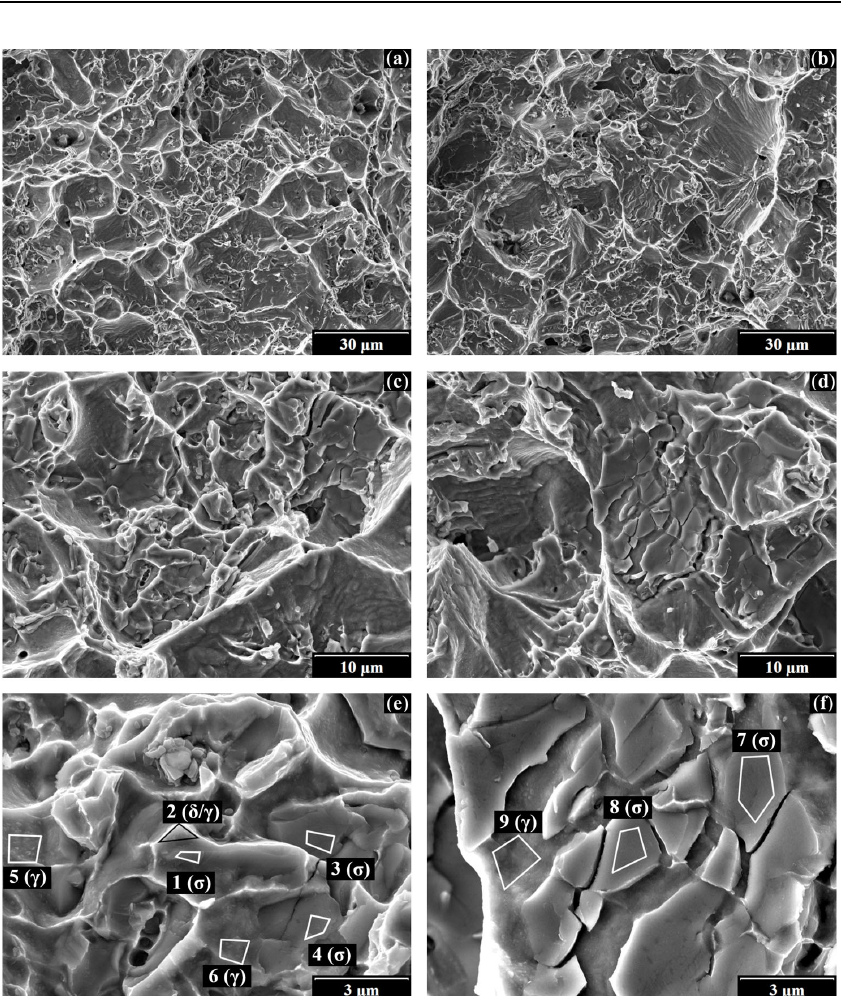
Figure 6. Fractographic features identified in two sites (( a , c , e ), and ( b , d , f )) of specimen T5 characterized by a very low ductile tearing resistance, J 0.2 . At low magnifications ( a , b ), the overall fracture surface appearance resembled that of specimen T4 (Figure 6). At elevated magnifications ( c , d ), numerous particles cracked in an evidently brittle manner were recognized. The contents of elements within particles were found to be consistent with areas identified as sigma phase on metallographic samples. The results of EDX analysis are listed in Table 3. Table 3. Results of EDX analysis performed in sites 1–9 depicted in Figure 6: amounts of relevant elements in wt. %, and identification of phases.